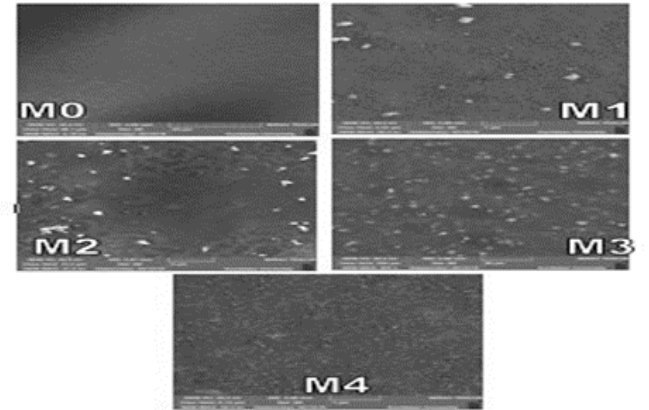
Figure 4. SEM of cross-section of the synthesized membranes